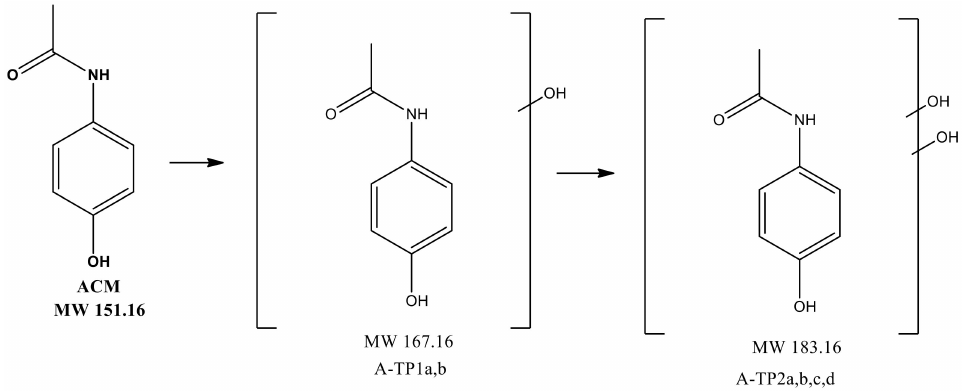
Figure 12. TPs products generated from ACM by PEF/TiO 2 20 wt% under